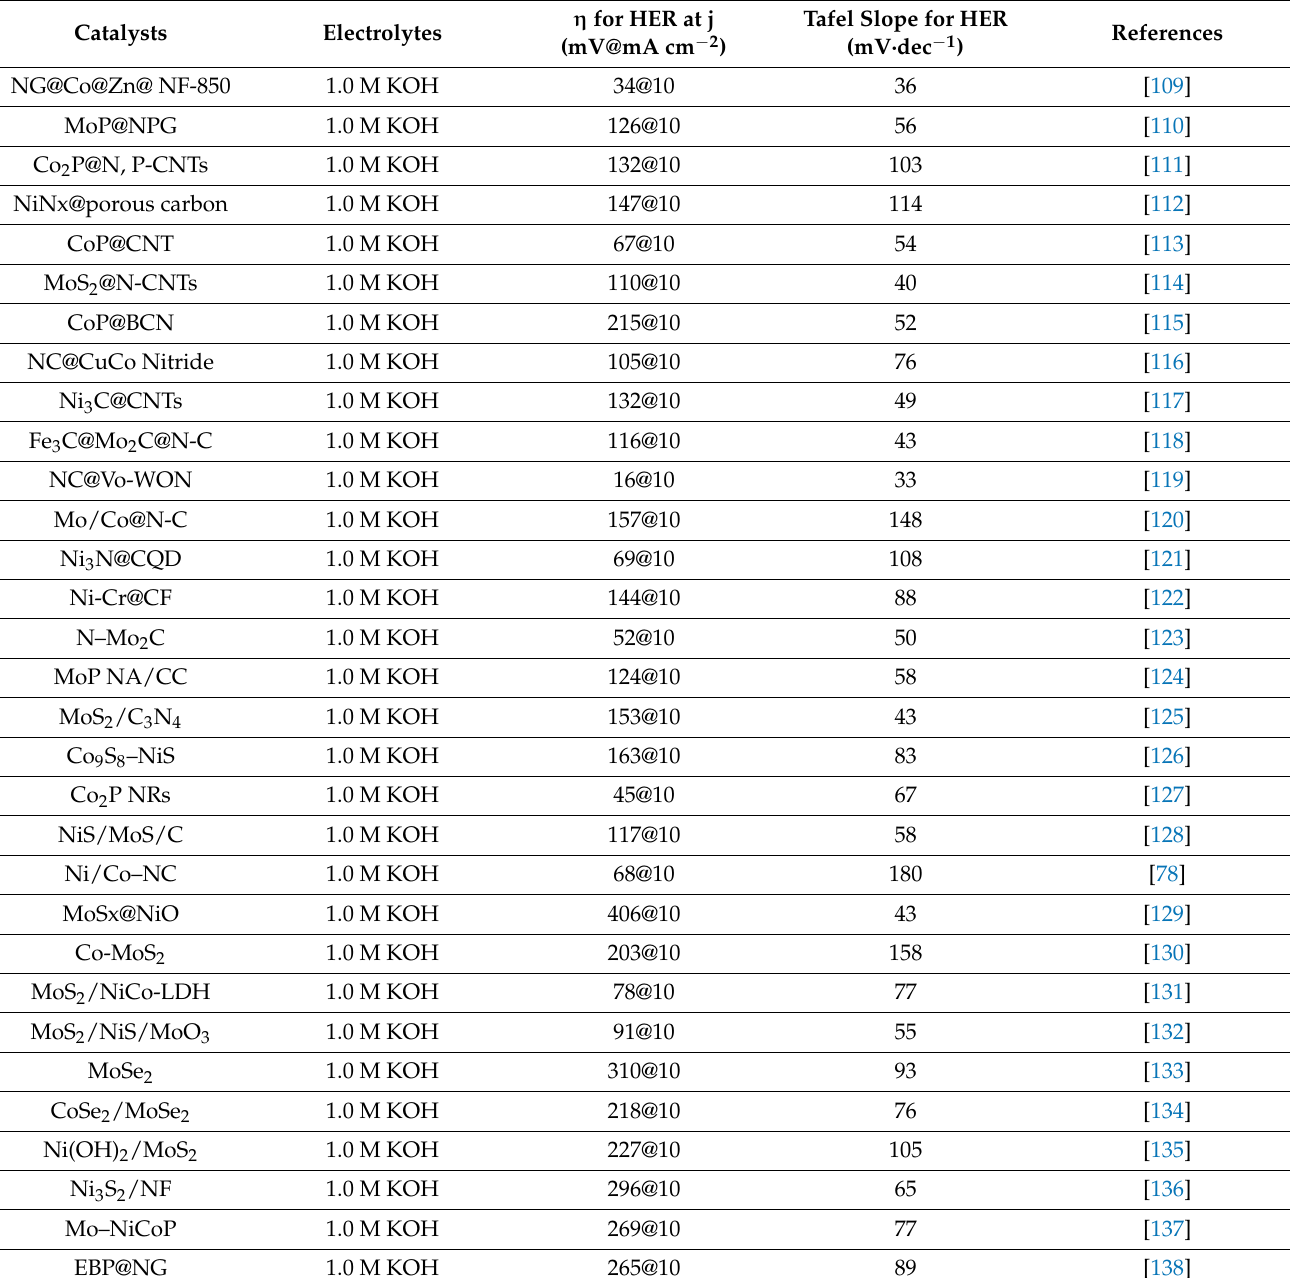
Table 1. The overview of the hydrogen evolution reaction (HER) performances of recently recorded electrocatalysts for water